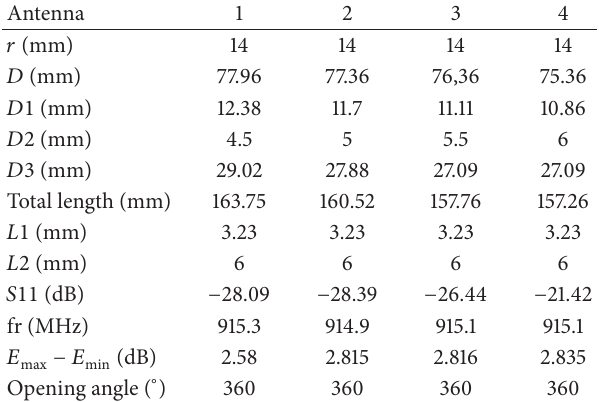
Table 9: Dimensions of each 3D spherical antenna (Figure 18) with the simulation results.